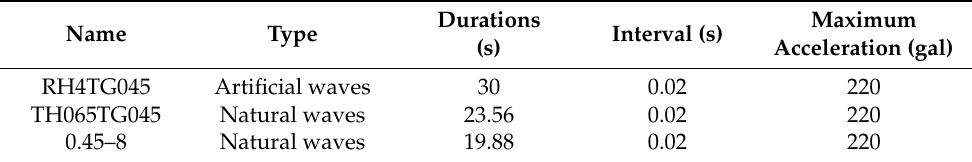
Table 14. Parameters of the three indicated ground-motion